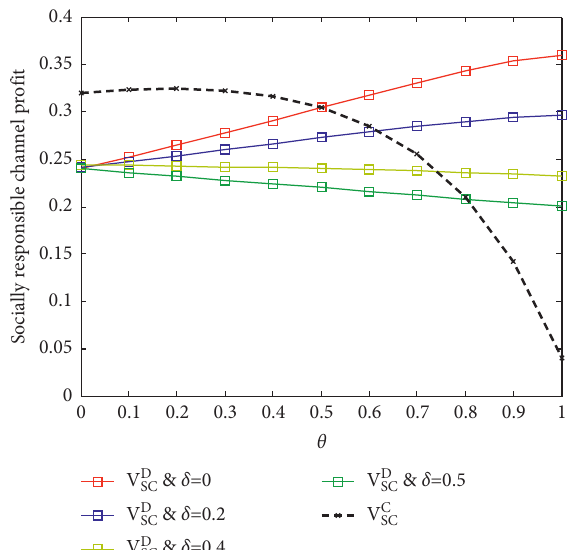
Figure 3: The joint impacts of δ and θ on the socially responsible channel